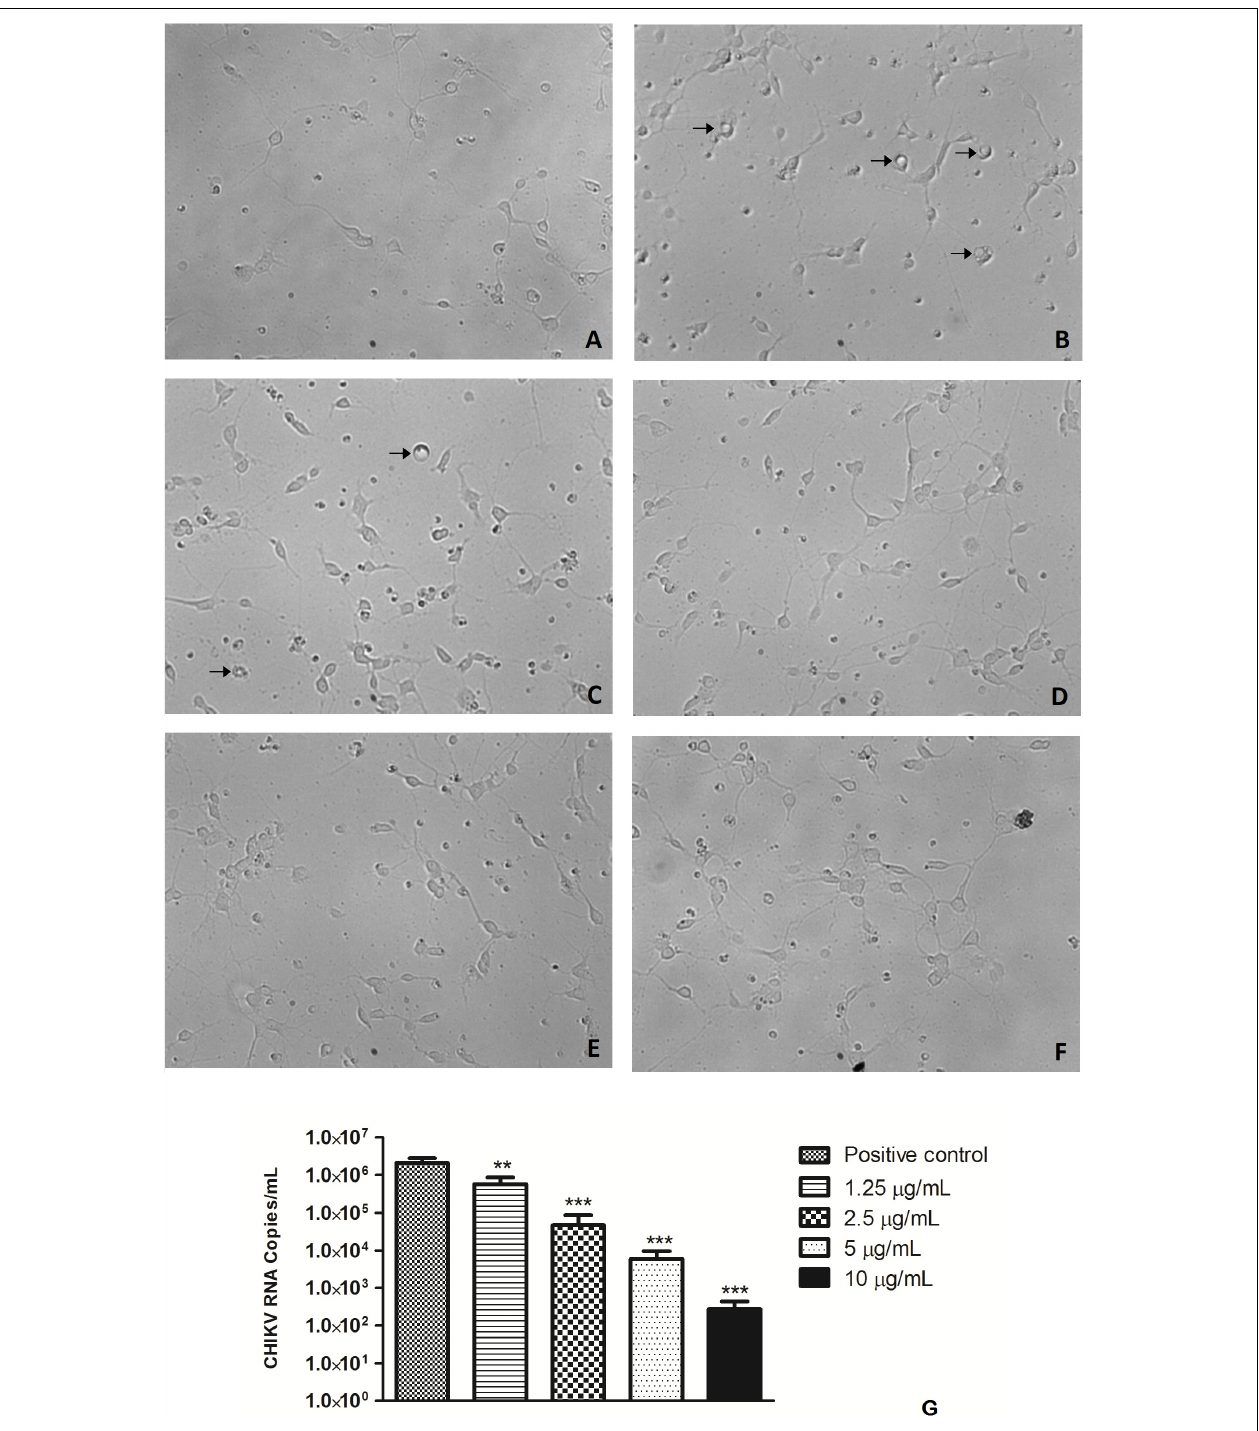
FIGURE 4 | Effect of O. obtusiloba extract on CHIKV replication in chick retina neurons in 4-day-old purified cultures. (A) Uninfected culture with normal morphology. (B) CHIKV-infected culture presenting cytopathic effect (arrow). (C) CHIKV-infected culture incubated with 1.25 µ g/mL of O. obtusiloba presenting cytopathic effect (arrow). (D) CHIKV-infected culture incubated with 2.5 µ g/mL of O. obtusiloba with normal morphology. (E) CHIKV-infected culture incubated with 5 µ g/mL of O. obtusiloba with normal morphology. (F) CHIKV-infected culture incubated with 10 µ g/mL of O. obtusiloba with normal morphology. Chick retina neurons were infected with CHIKV (10 6 PFU/mL) at MOI of 0.1. (G) Graphical representation showing the effect of O. obtusiloba extract at concentrations of 1.25, 2.5, 5, and 10 µ g/mL on CHIKV genomic RNA by quantitative PCR. The results showed that all treatments with the extract showed a significant reduction of RNA copies. Error bars indicate the standard deviation and experiments were performed in triplicate. ∗∗ p < 0.01; ∗∗∗ p < 0.001 in Tukey test.